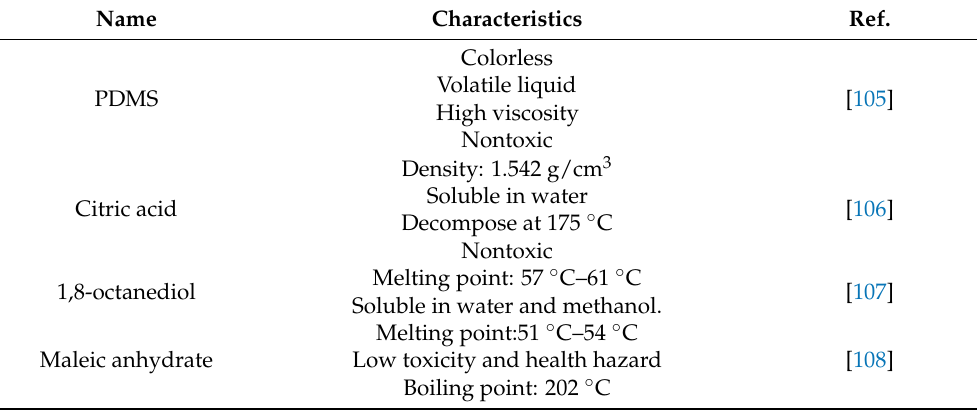
Table 4. Main characteristics of the elastomer